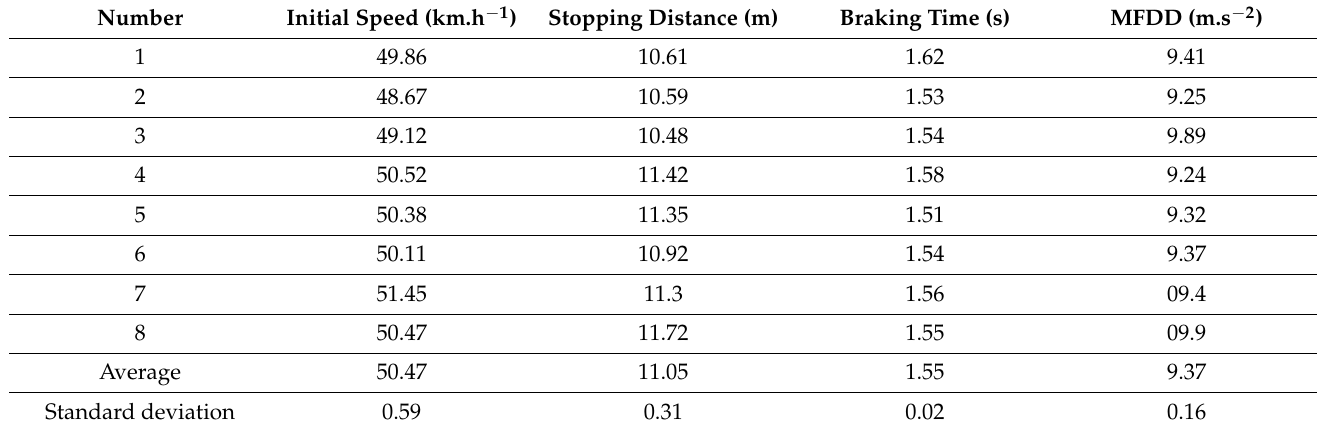
Table 11. Braking characteristics measured with high-priced brake components.